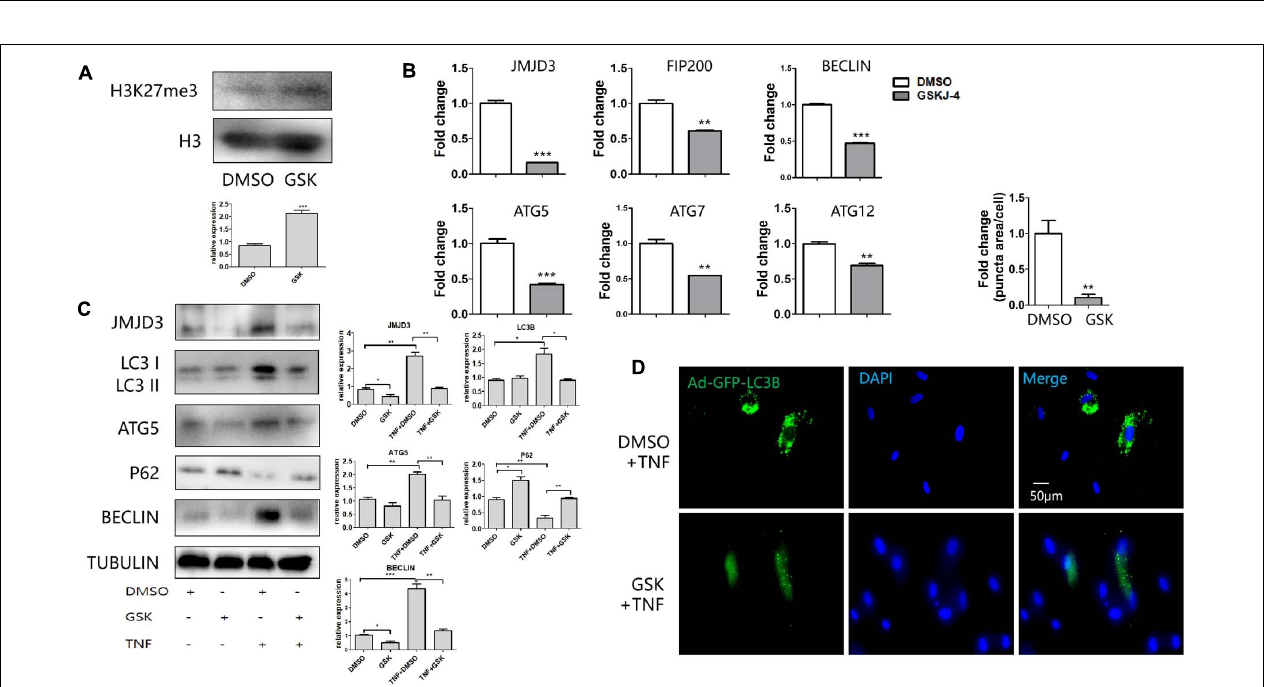
FIGURE 3 | GSKJ-4 mediated the decrease of autophagy genes. (A) Western blot analysis of H3K27me3 level in response to GSKJ-4 treatment. Below was the relative quantification of the bands. (B,C) QPCR (B) and western blot (C) analysis of JMJD3 and several autophagic genes after the treatment of GSKJ-4. The relative quantification was on the right. (D) GFP-LC3 puncta and the corresponding quantitative analysis (up) in response to GSKJ-4 treatment. The relative quantification was on the upper side. ** P < 0.01, *** P < 0.001.